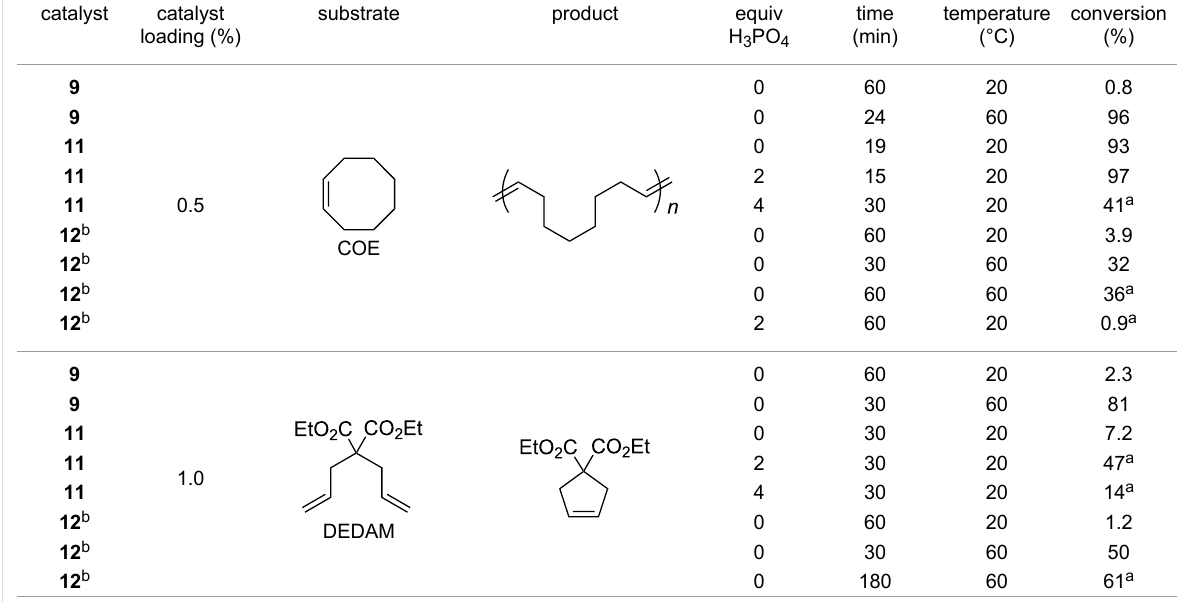
Table 2: ROMP and RCM reactions with catalysts 8–10 in C 6 D 6 ([Ru] = 0.5 mM for 0.5 mol %, 1.0 mM for 1 mol % loading).